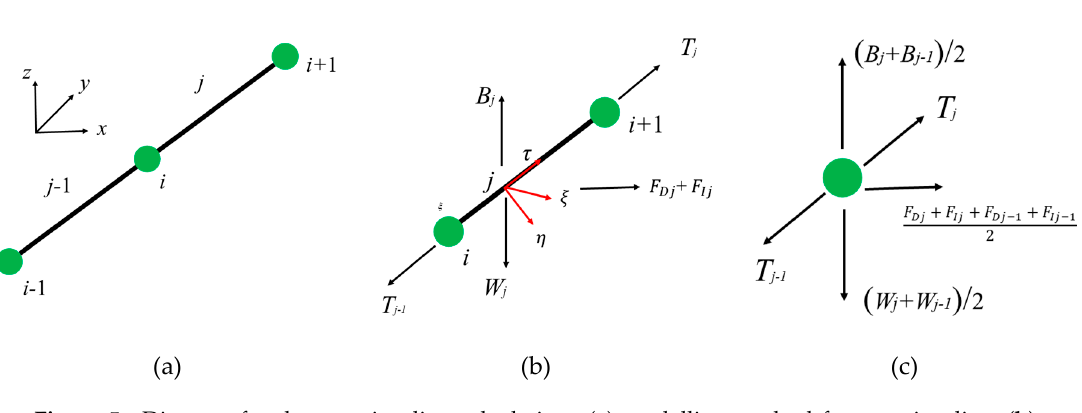
Figure 5. Diagram for the mooring line calculation: ( a ) modelling method for mooring line, ( b ) calculation for element; ( c ) calculation for node.